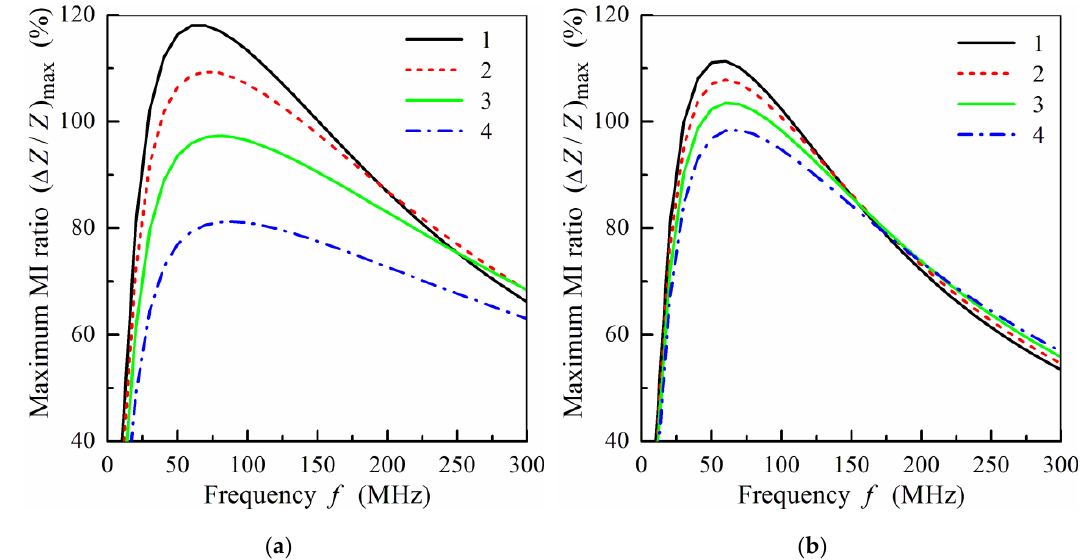
Figure 7. ( a ) Frequency dependence of the maximum MI ratio, ( ∆ Z / Z ) max , at m = 4, d 2 = 100 nm, and di ff erent values of n : curve 1, n = 4; curve 2, n = 3; curve 3, n = 2; curve 4, n = 1. ( b ) Frequency dependence of the maximum MI ratio, ( ∆ Z / Z ) max , at m = 9, d 2 = 50nm, and di ff erent values of n : curve 1, n = 9; curve 2, n = 8; curve 3, n = 7; curve 4, n = 6. Other parameters used for calculations are the same as in Figure 2.